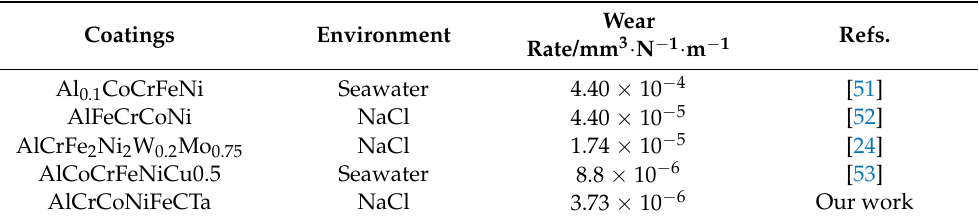
Table 6. Comparison of wear rates of high-entropy alloy coatings in corrosive solutions between our work and the relative references.